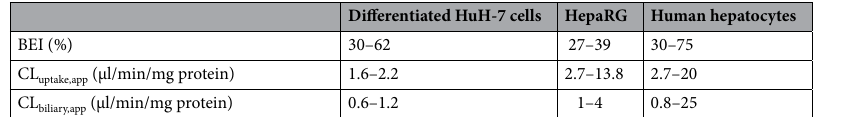
Table 1. Summary of biliary excretion index (BEI), apparent in vitro uptake clearance (CL uptake,app ) and biliary clearance (CL biliary,app ) of radiolabeled taurocholate ([ 3 H]-TCA) in differentiated HuH-7 cells compared with previously published data in HepaRG cells and human hepatocytes 13 . Differentiated HuH-7 cell data are from Figs. 6b, c, and